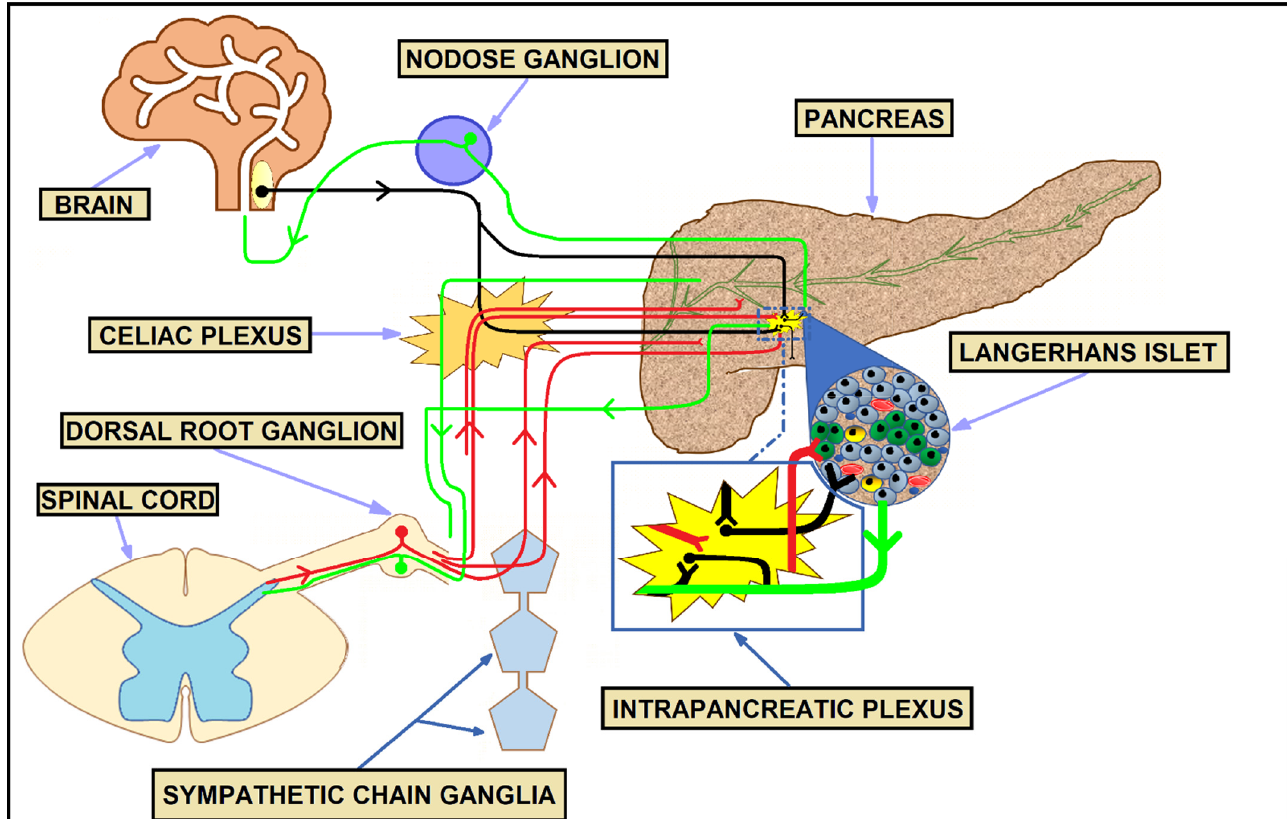
Figure 1. Autonomic and sensory innervation of the healthy pancreas. Green nerve cells—sympathetic neurons; red nerve cells—sympathetic neurons; black nerve cells—parasympathetic neurons.